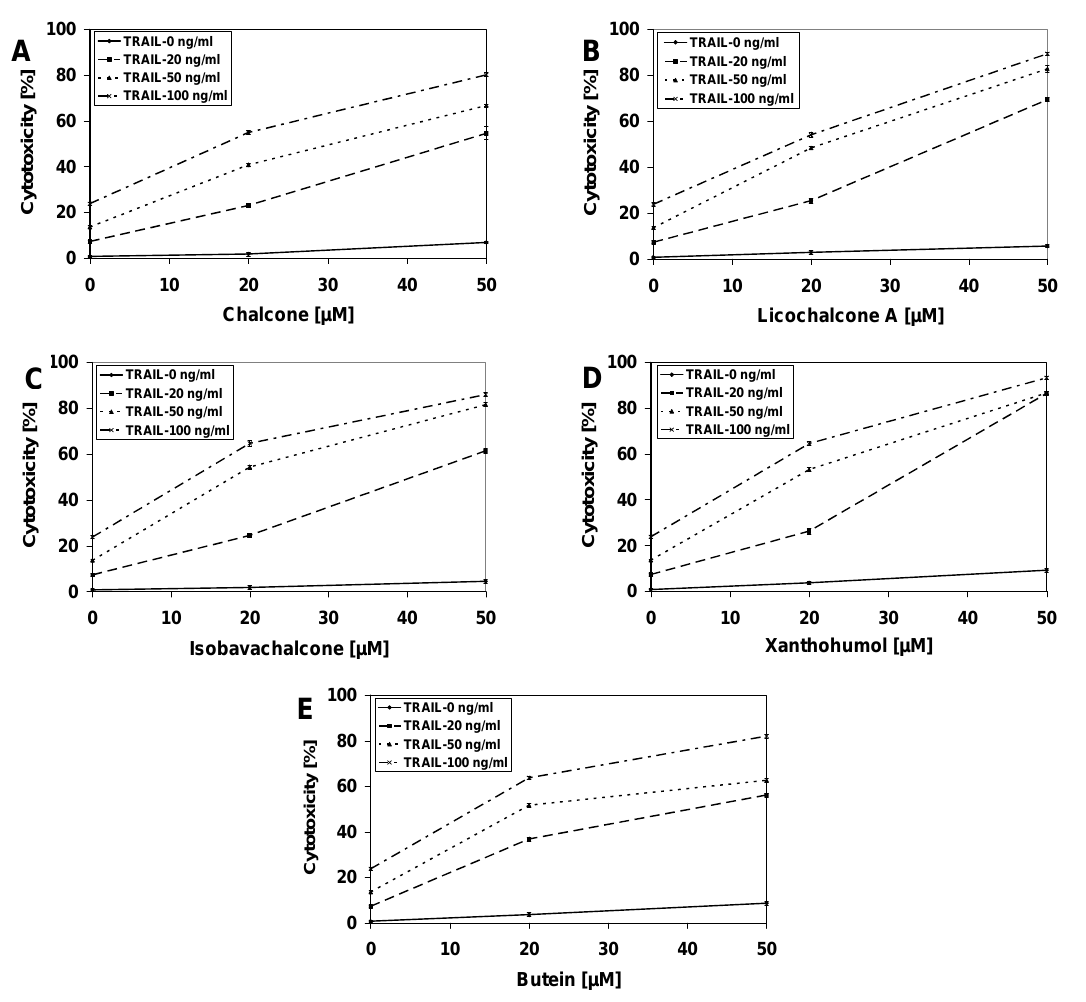
Figure 4. Cytotoxic activity of TRAIL in combination with chalcones in LNCaP prostate cancer cells. The cancer cells were incubated for 48 hours with TRAIL at the concentrations of 20–100 ng/mL and chalcones: (A) chalcone, (B) licochalcone-A, (C) isobavachalcone, (D) xanthohumol and (E) butein at the at the concentrations of 20 μ M and 50 μ M. The percentage of cell death was measured by MTT cytotoxicity assay. The values represent mean ± SD of three independent experiments performed in quadruplicate (n = 12) (p <